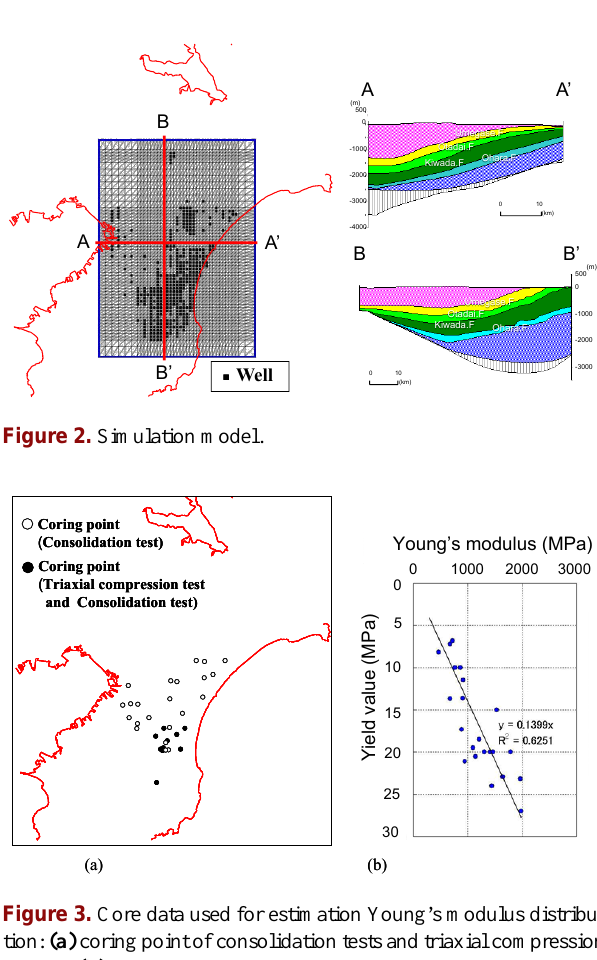
Figure 3. Core data used for estimation Young’s modulus distribu- tion: (a) coring point of consolidation tests and triaxial compression test and (b) correlation between yield value and Young’s